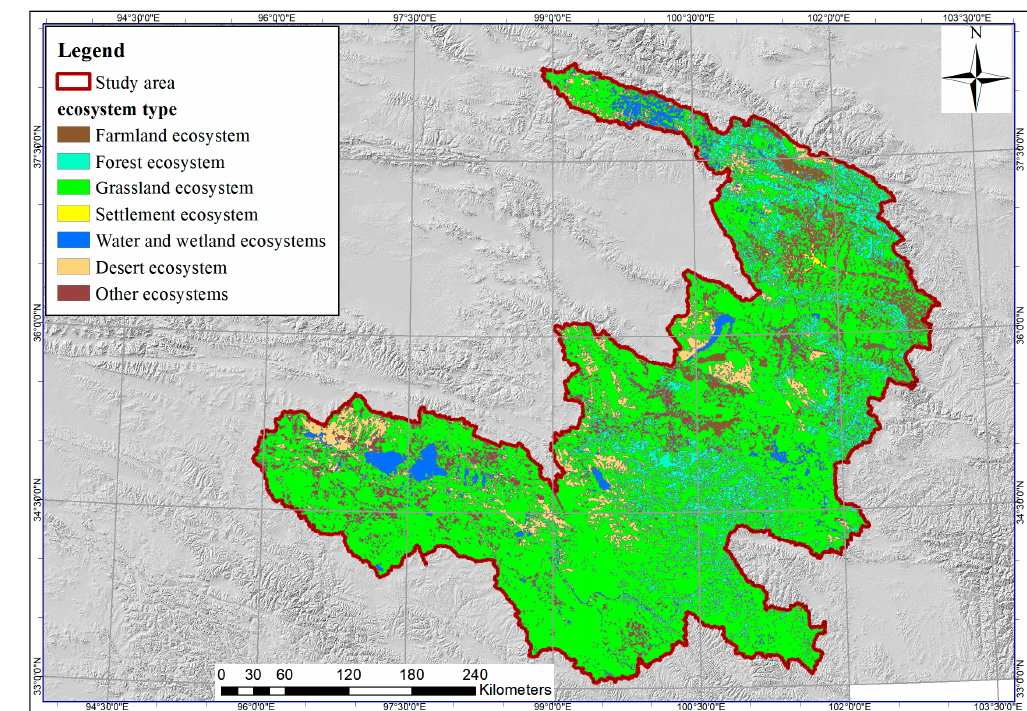
Figure 1. Schematic diagram of the distribution of ecosystems in the study area. Table 1. Research